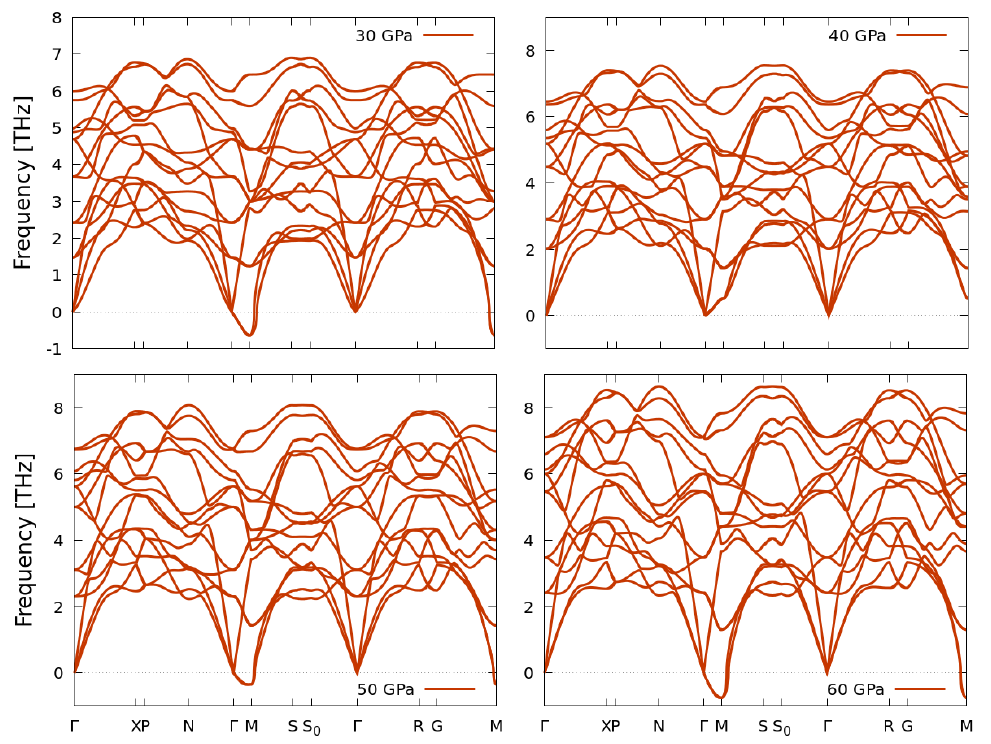
Figure 8. Harmonic phonon dispersion curves of the I4/mmm phase of the Sb 2 Se 3 compound between 30 and 60